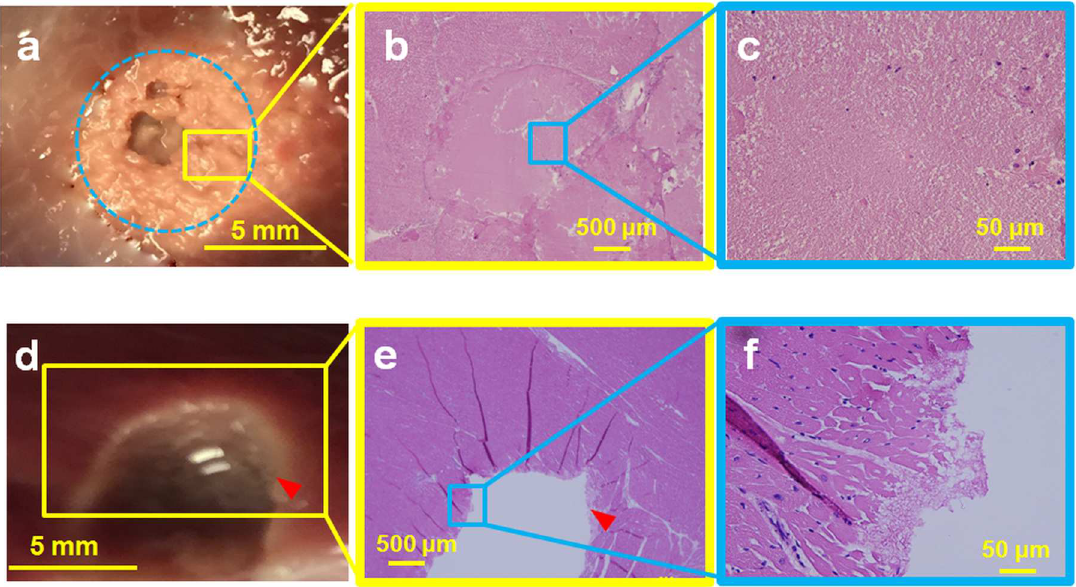
Fig 10. Ex vivo porcine liver (top panel) and cardiac muscle tissue (bottom panel) sonicated with 600 W at 5 Hz PRF. Top Panel: a . Gross pathologyof the lesion appearedthermally denatured,with a diameterof 8 mm (blue dotted circle). This area was not structurally intact and disintegrated duringpathologicalstain preparation process. b . H&E slide showingdiffuse thermal effects, with little cellularstructure. c . Magnification (40X) of the Fig 10b with parts of the lesion showingabsenceof cellularstructure, representing homogenization of tissue. Bottom Panel. d . Cardiacmuscle with a liquefiedvoid in the center of the lesion with sharp boundarywith negligiblethermal effects (red arrowhead). e . H&E slide of the lesion shows that cellular structure aroundthe void was intact, with no evidenceof thermal damage. The lesion also has sharp boundaries(red arrowhead). f . Magnification (40X) of the lesion boundary, with most of the boundarytissue intact.